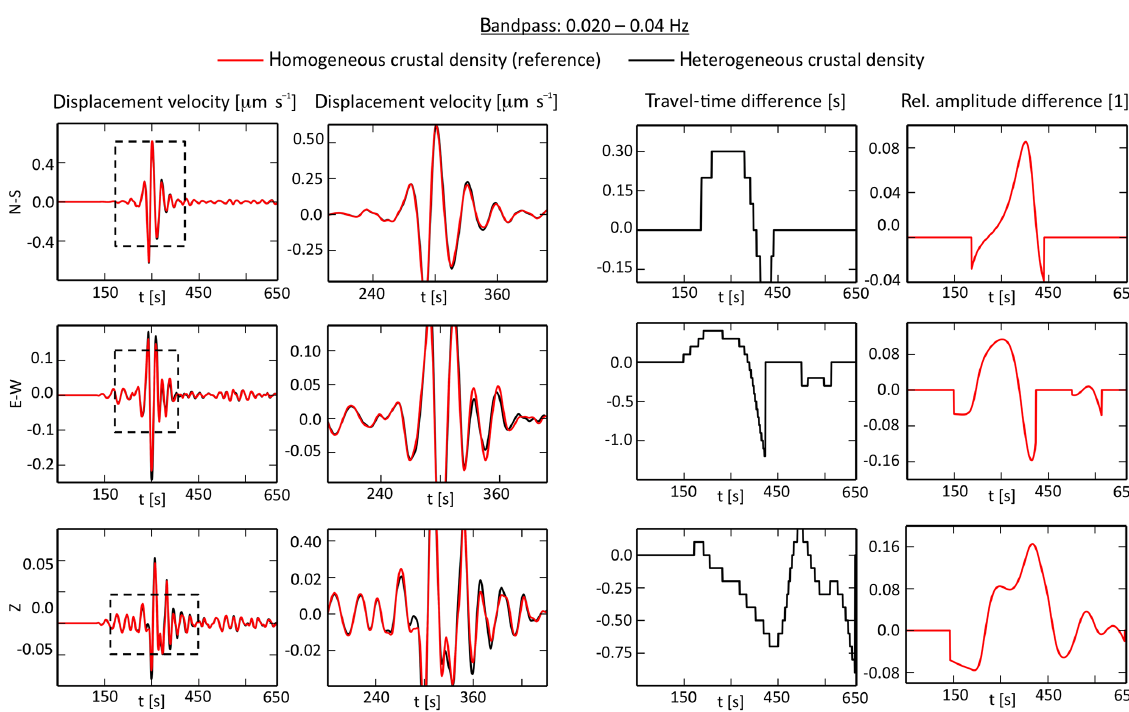
Figure 5. The same as in Fig. 3 but for the narrowest frequency band from 0 . 02 to 0 . 04Hz (25–50s).